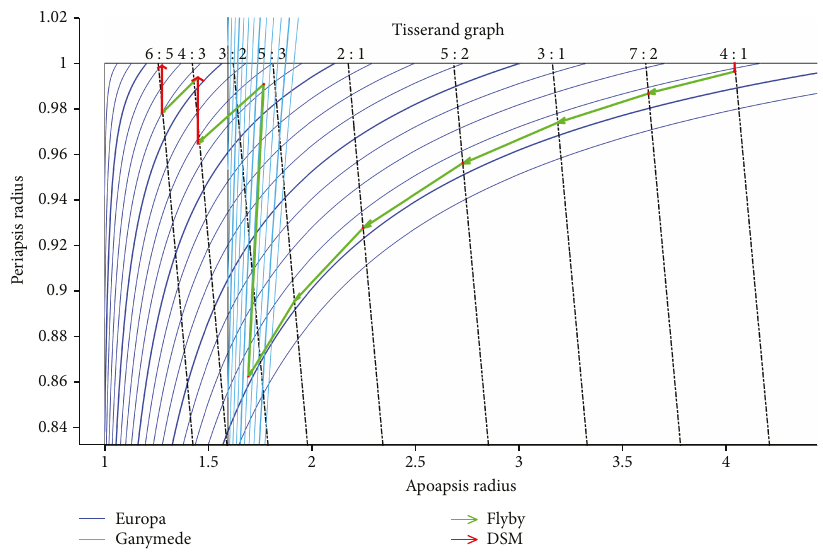
Figure 11: Tisserand graph of solution C. Axes are normalized with respect to the Europa semi-major